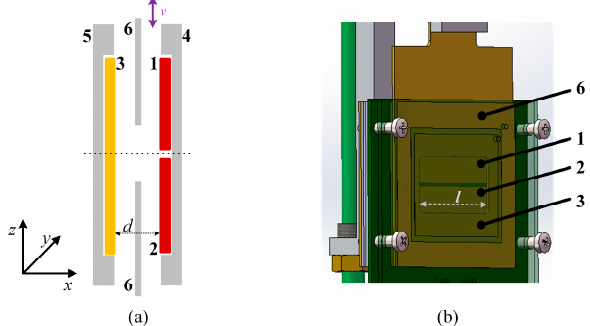
Figure 1. Schematic of differential capacitive sensor. ( a ) 2D schematic of differential capacitive sensor; ( b ) 3D schematic of differential capacitive sensor. ( b ) 3D schematic of differential capacitive